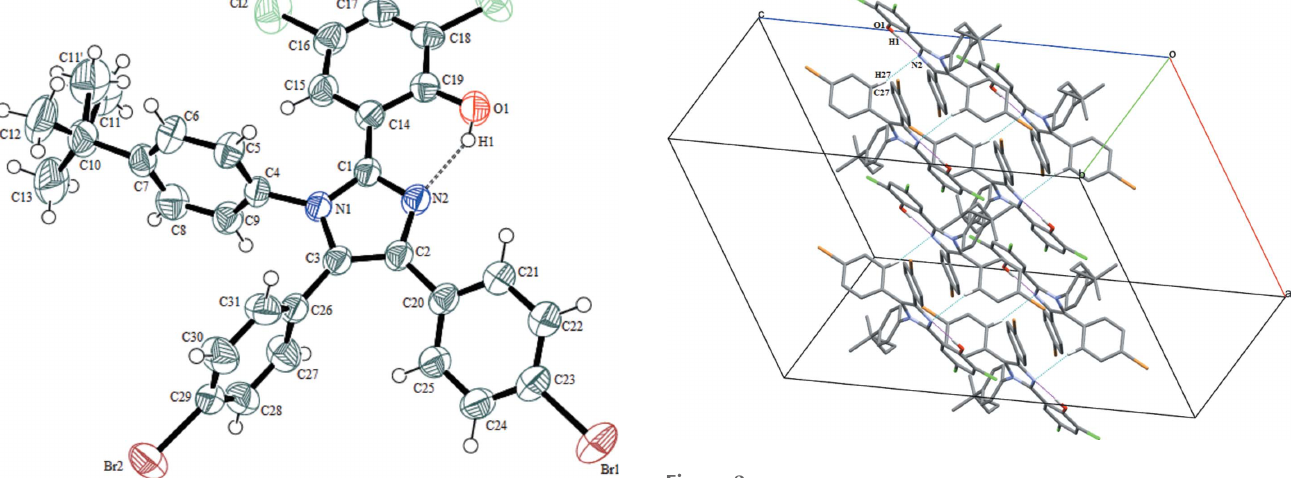
Figure 2 Unit-cell packing of the title compound showing intermolecular C— H (cid:4)(cid:4)(cid:4) N interactions with dotted lines. H atoms not involved in hydrogen bonding have been excluded.